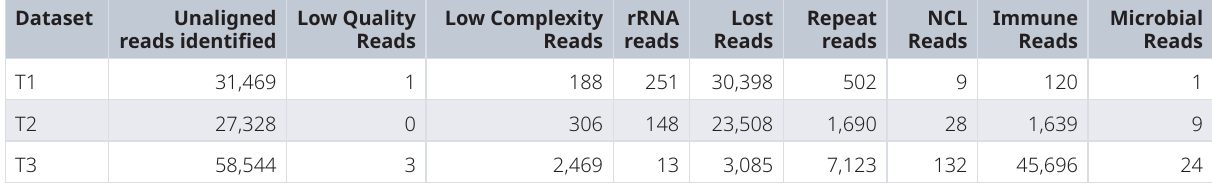
Table 4. Unaligned reads identified by ROP in the simulated